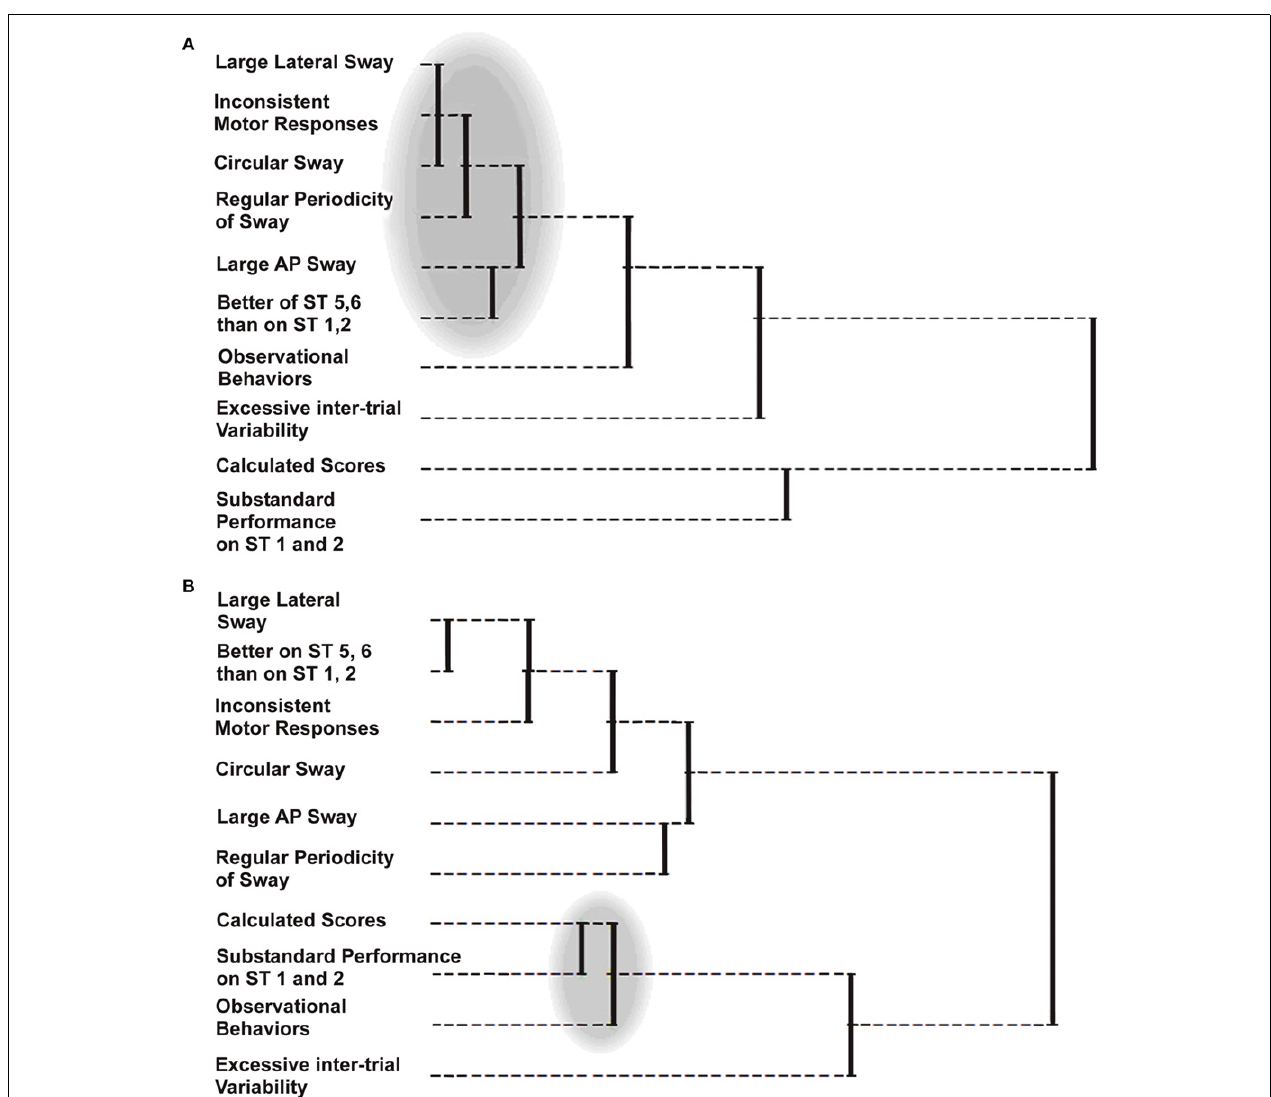
representing the less frequently occurring criteria (shaded area). (B) The dendrogram for the psychogenic group identified a clear grouping of three criteria representing the most frequently occurring criteria (shaded area). In addition, a cluster was formed between large lateral sway and better on ST 5, 6 than on 1, 2 and another cluster consisting of large AP sway and regular periodicity of